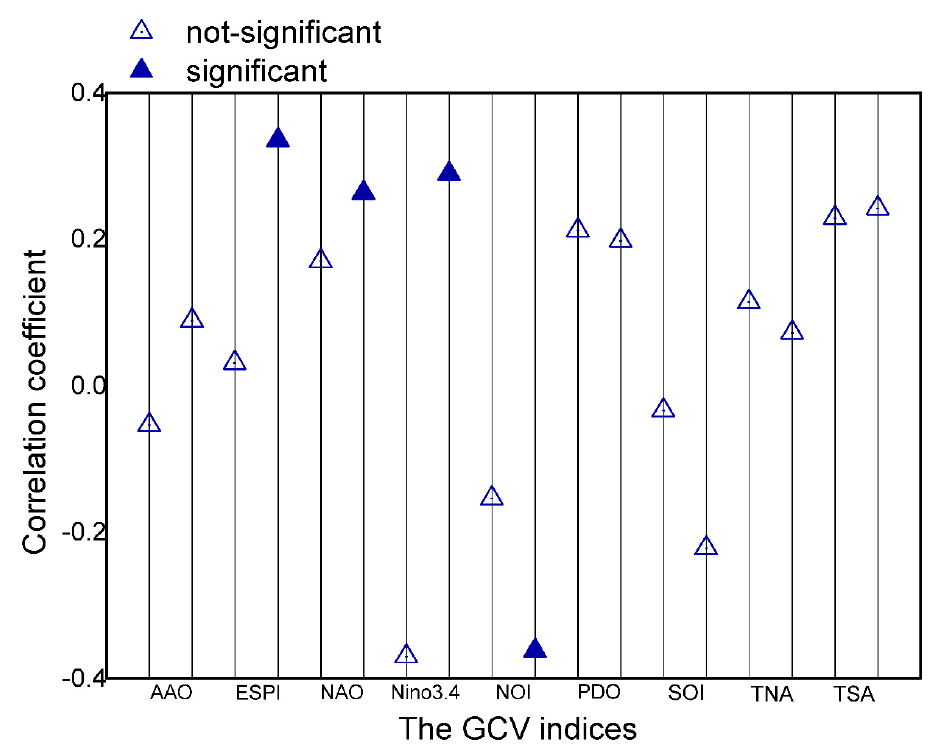
Figure 6. The results of lag analysis. The blue hollow triangle represents a not-significant correlation coefficient. The blue solid triangle represents a significant correlation coefficient after a one-year lag. ( p < 0.05).